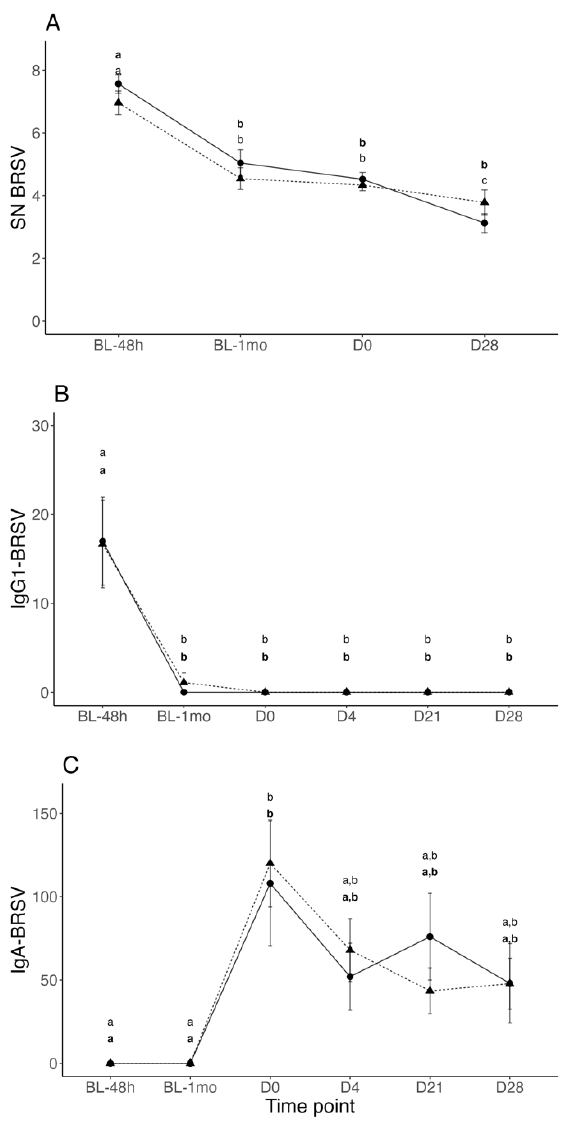
Figure 4. Mean ± SEM serum neutralizing (( A ), log 2 transformed), nasal BRSV immunoglobulin G1 ( B ), and nasal BRSV immunoglobulin A ( C ) antibody titers at 48 h of life (BL-48 h), 1-month of age (BL-1 mo), and days 0 [challenge day], 21, and 28 after BRSV challenge of calves vaccinated intranasally (IN) with a modified-live virus (MLV) BRSV vaccine in the first 6 h of life (dashed line and triangles) versus control calves (solid line and circles) subsequently challenged with BRSV. Data were analyzed using generalized mixed-effects models. Distinct letters (small caps a, b, c) represent significant ( p < 0.05) difference between time-points within participants of each group (vaccinated in bold). Familywise multi comparisons were performed using Tukey–Kramer with Bonferroni correction. Statistically significant differences between groups were not observed at any time